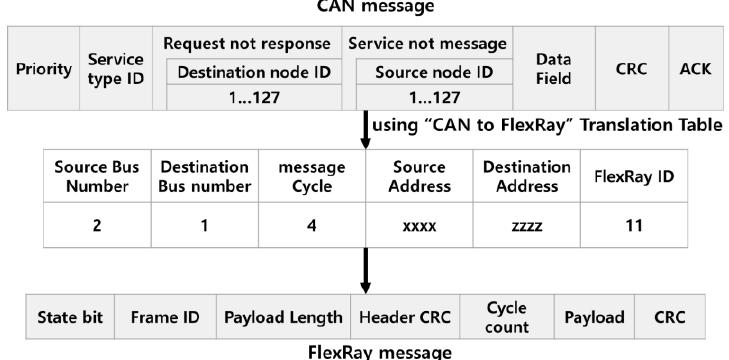
Figure 8. The Translation of a CAN into a FlexRay message by Translation Table.